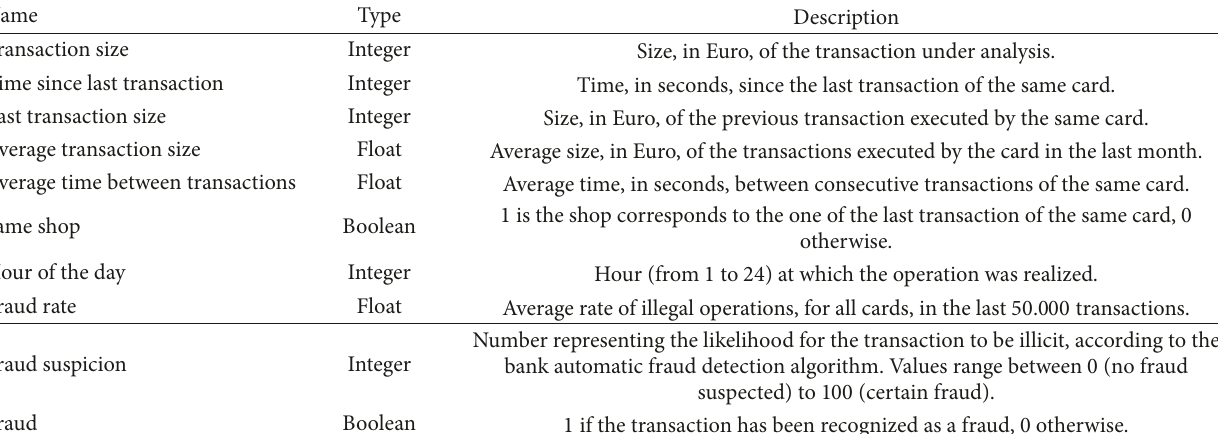
Table 3: Features composing the credit card transactions dataset.